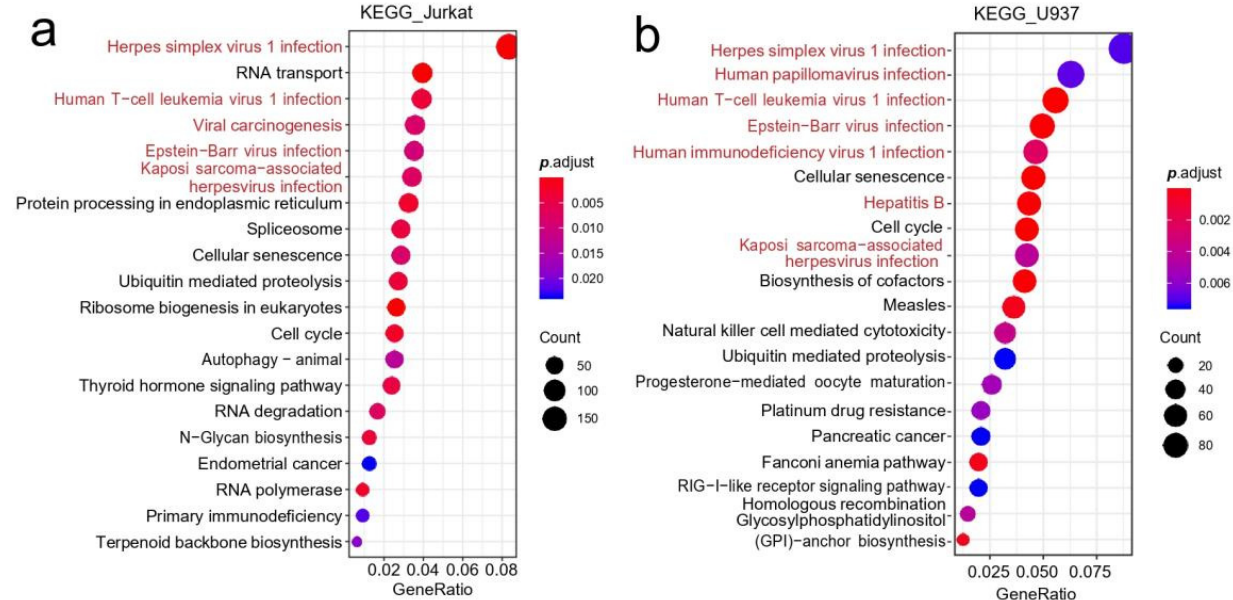
Figure 4. KEGG significant enrichment pathways of differently expressed genes of U937 cells and Jurkat T cells. In Jurkat T cells ( a ), five significant enrichment pathways associated with viral infection were found: HSV1 infection, HTLV1 infection, EBV infection, KSHV infection and viral carcin ‐ ogenesis. In U937 cells ( b ), seven significant enrichment pathways associated with viral infection were also found: HSV1 infection, HPV infection, HTLV1 infection, EBV infection, HIV1 infection, and Hepatitis B virus (HBV) infection and KSHV infection. The horizontal axis represents GeneRa ‐ tio, which is the ratio of genes enriched in the corresponding pathway to the input genes; the pot size in the figure is determined by the number of genes enriched in the corresponding pathway and the pots in the figure are arranged from the top to bottom as the number gets smaller; the node color is determined by adjusting p ‐ value, which is the false discovery rate provided by the KEGG enrich ‐ ment tool.